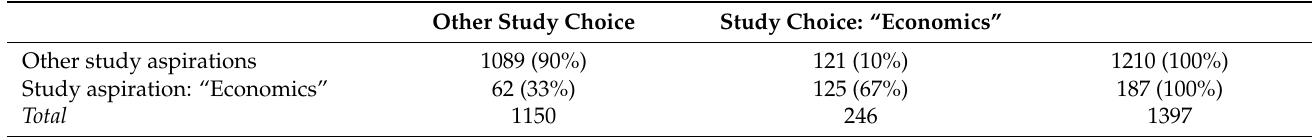
Table 9. Study aspiration and choice of the field of study.